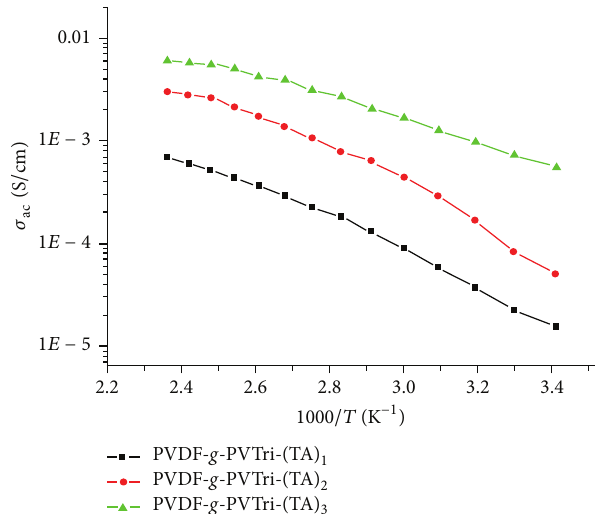
Figure 8: Variation of the DC proton conductivity of PVDF- g - PVTri-(TA) 𝑥 ( 𝑥 = 1.0 , 2.0 and 3.0) membranes as a function of reciprocal temperature.